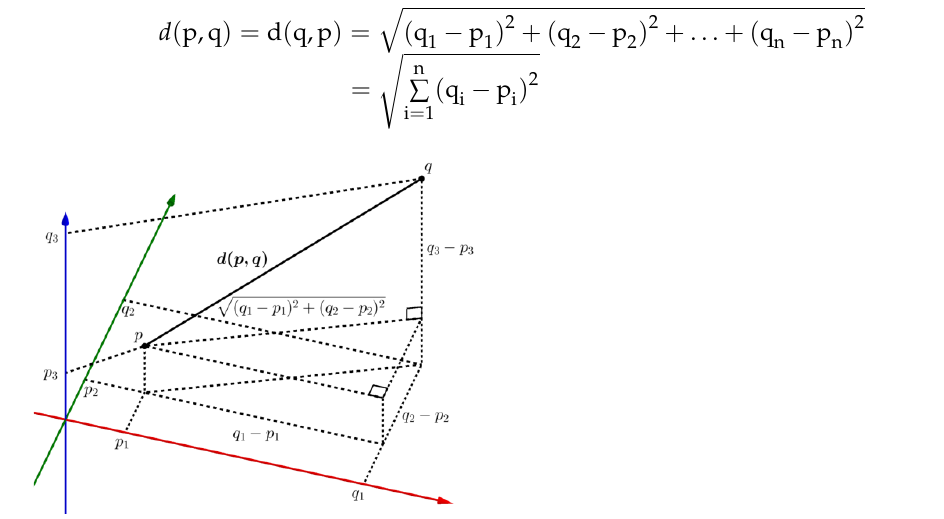
Figure 3. Euclidean distance between points p and q .